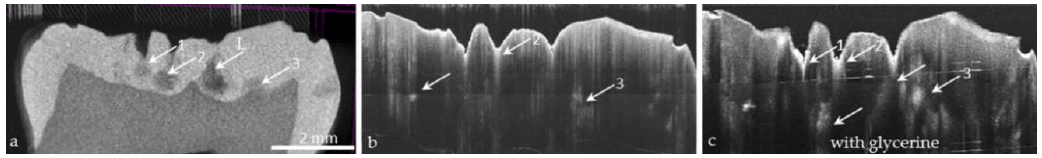
Figure 9. Extracted human molar with occlusal carious lesions without cavitation (L). ( a ) μ CT image of ROI. After application of glycerin gel signal ‐ to ‐ noise ratio in the SD ‐ OCT cross ‐ sectional image ( c ) can be improved towards the image ( b ) (without glycerine, white arrows) leading to an adequate conformance of μ CT with OCT.